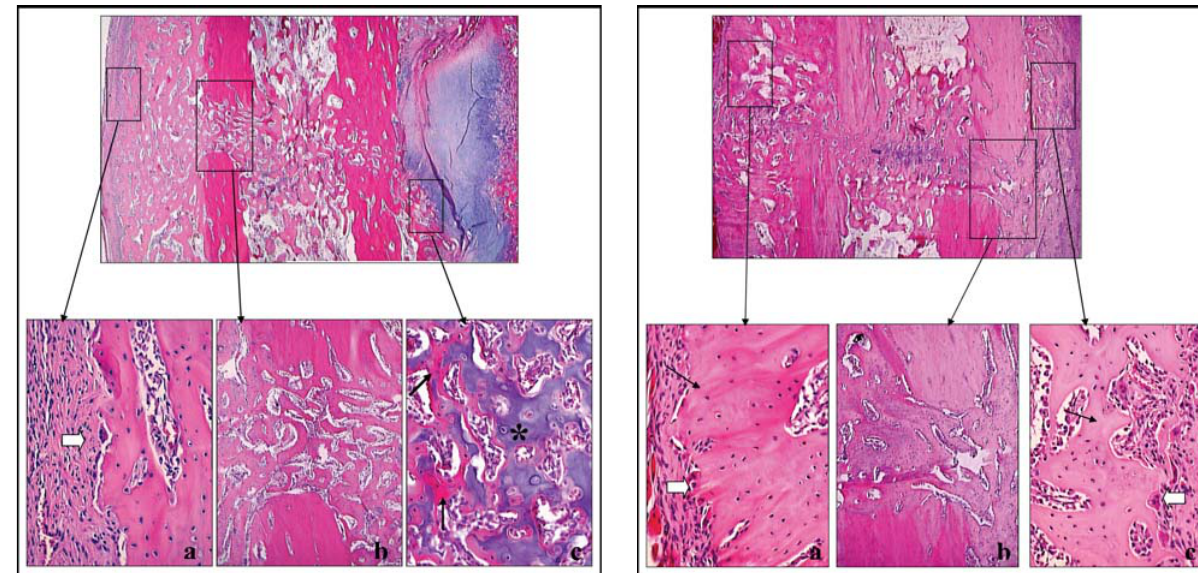
FIGURE 1 - Fracture site of the control forelimb at 30 days postoperative. Observe the presence of bone callus involving the fracture edges (general aspect) and the union of the cortical bone with primary bone tissue (b). At the external region of the bone callus is observed reabsorption of the bone surface by osteoclasts (large arrow) and facing the ulna there is a great amount of cartilaginous tissue (c) (asterisk) being replaced by interwoven bone tissue (arrows). HE, x10, x200, x 40 and x200.